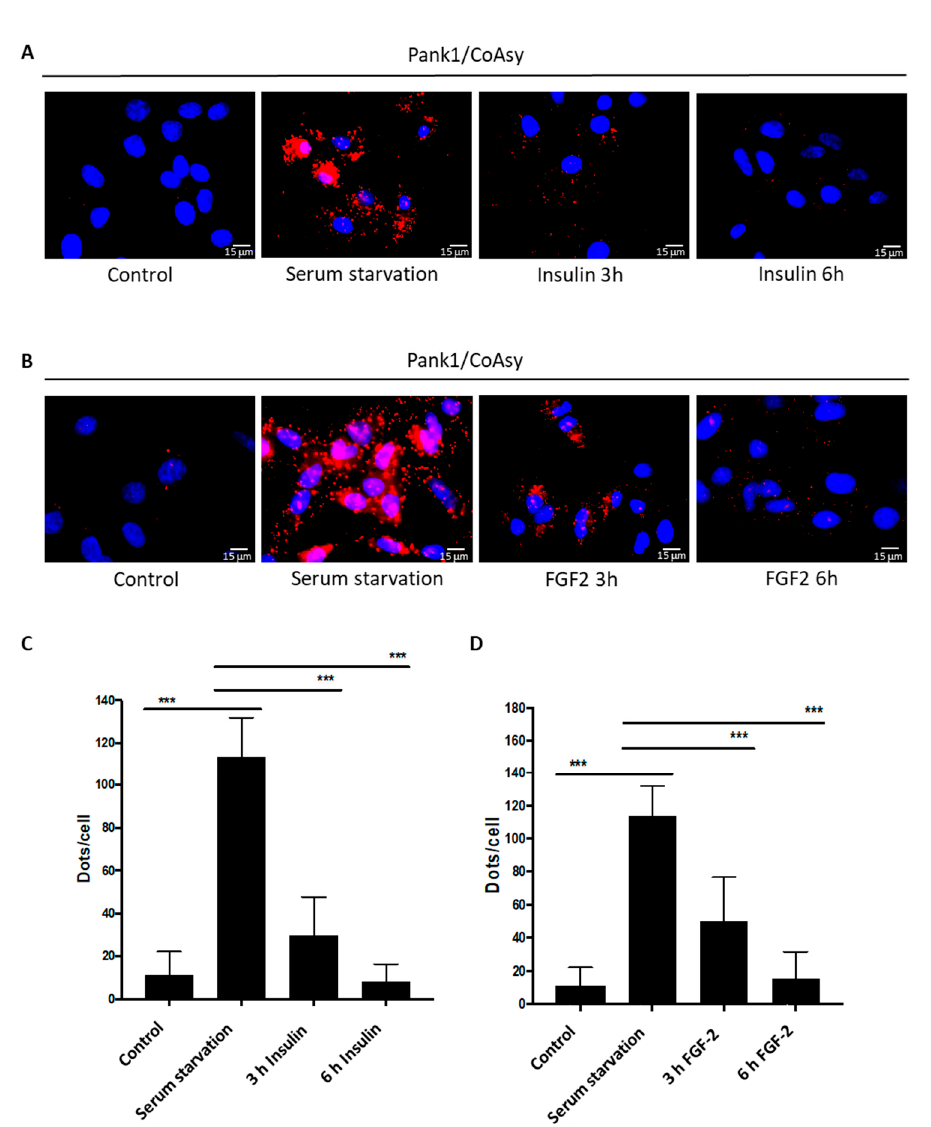
Figure 6. Insulin and fibroblast growth factor 2 (FGF-2) inhibit the interaction between Pank1 and CoAsy in A549 cells. Pank1 and CoAsy interaction is inhibited in response to insulin ( A ) and FGF-2 ( B ) treatment in A549 cells. Cells were starved for 24 h and treated with 1 µ M insulin or 100 ng/mL FGF2 for 3 h or 6 h. Control cells were not starved or treated. Nuclei are stained with DAPI (blue); proximity ligation assay (PLA) was performed for Pank1 and CoAsy (Red). Scale bars: 15 µ m. Data are representative of three independent experiments. ( C , D ) Relative quantitation of Pank1/CoAsy assembly in control, serum starved, and insulin or FGF-2 treated A549 cells from ( A , B ). Dots/cell counted. Data represent mean ± SEM from n = 3 experiments (*** p < 0.001).